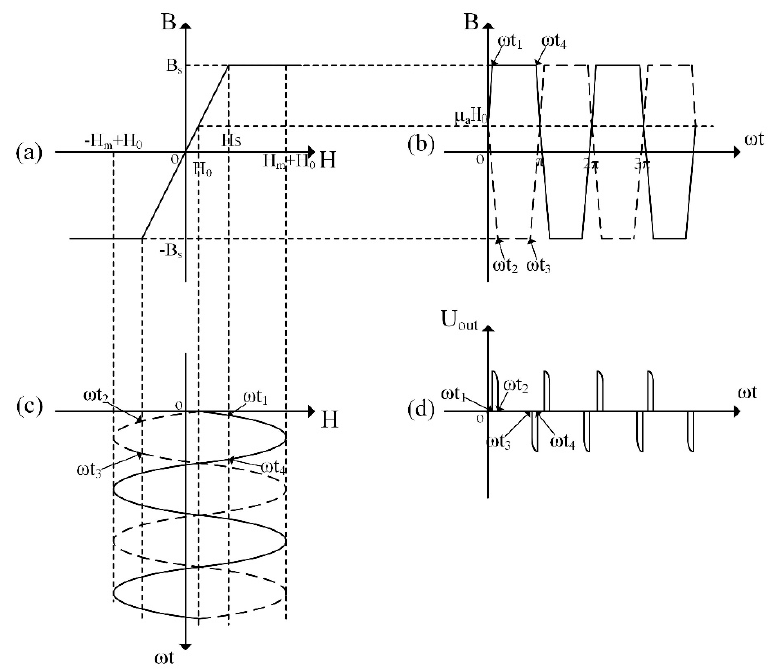
Figure 2. Schematic diagram of the working principle of the dual-core magnetic fluxgate sensor. ( a ) the simplified hysteresis line of the core ( b ) the core’s magnetic induction intensity ( c ) the core’s magnetic field intensity ( d ) the output voltage of the induction coil.